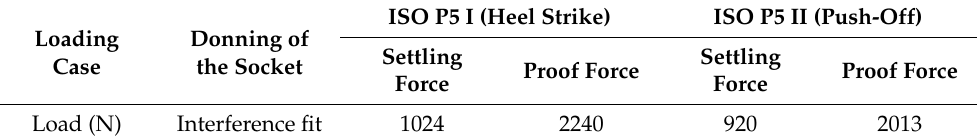
Table 3. Summary of loading cases with corresponding